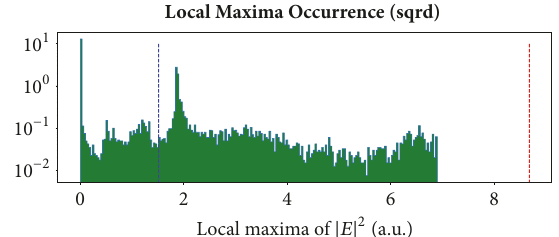
Figure 3: Histogram of the number of intensity peaks as a function of the intensity maxima for the temporal sequence of Figure 2. The dashed lines indicate the position of the average of the maxima intensity and the intensity corresponding to the average value plus four times the standard deviation which is the limit corresponding to the definition of rogue wave.